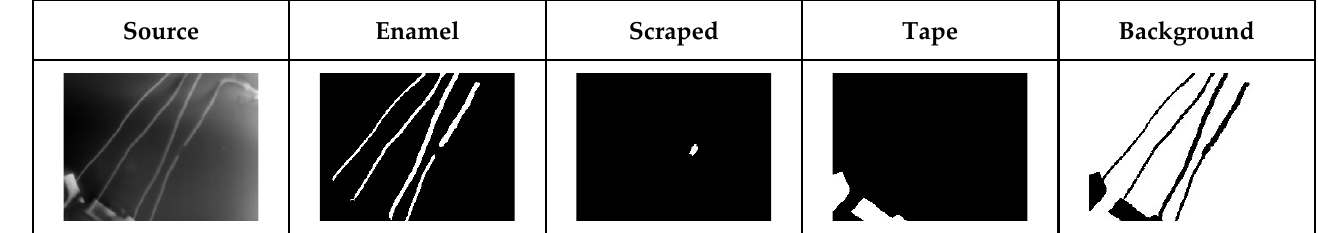
Figure 7. Example of material masks constructed and source image. Three different classifier models: a k-means clustering algorithm, Gaussian Mixture Model with expectation maximisation (GMM-EM), and support vector machines (SVM) were trained in two different ways. The first was to identify the cooling periods by their respective material, as specified by the training masks shown earlier. A separate model was also trained to classify whether or not the pixel contained enamel. The two-class model consisted of classes as enamel and copper, whereas the four-class model would contain classes as copper, enamel, background, and fixing tape. A two-class model would be ideal for a live system as it would return a binary image which would be easier to process. Both models were tested to see which would perform better. 4.2.1. K-Means Clustering Algorithm The first model tested was the popular k-means clustering algorithm. It is a common method for separating data into k-groups. The groups or clusters are defined by their cen- tre and are iteratively adjusted as more data are introduced [34]. This well-defined algo- rithm could be easily trained. The training accuracy in the following plots is on a scale of 0 to 1, with 1 representing 100%. The training accuracy varied between approximately 20% and 90% for four classes (copper, enamel, background, and tape), Figure 8a. It also varied with different files which suggest the sensitivity of the model. The accuracy became more consistent for 2 classes when the 2nd derivative was used, achieving an accuracy of around 90% for 5 out of the 7 files in the plot, as shown in Figure 8b. ( a ) ( b ) Figure 8. K-means training accuracy for each file using both the cooling period and derivatives of the cooling period. ( a ) The plot is showing results for four classes (copper, enamel, background, and tape), and ( b ) the plot is showing results for two classes (copper and enamel). 4.2.2. Gaussian Mixture Model with Expectation Maximisation (GMM-EM) A Gaussian Mixture Model with expectation maximisation was tested next. As pro- posed by Stauffer and Grimson [35] this method provides a means of classifying objects